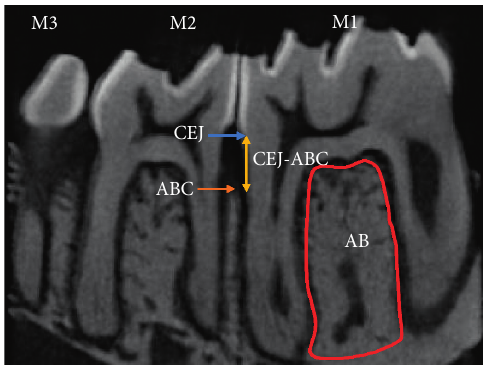
Figure 2: Alveolar bone morphometric analysis area. Analysis of alveolar bone morphometry was done at the interradicular bone of first molar, represented by the red line. Bone volume fraction (BV/ TV), trabecular number (Tb.N), trabecular thickness (Tb.Th), and trabecular separation (Tb.Sp) were analyzed. Alveolar bone loss height was measured at the distance between CEJ to ABC . CEJ-ABC represented by at all four sites of mesiolingual (ML), mesiobuccal (MB), distolingual (DL), and distobuccal (DB) sec- tions of the first molar. AB, alveolar bone; CEJ, cementoenamel junction; ABC, alveolar bone crest; CEJ-ABC, distance of cementoenamel junction to alveolar bone crest; M1, first molar; M2, second molar; M3, third